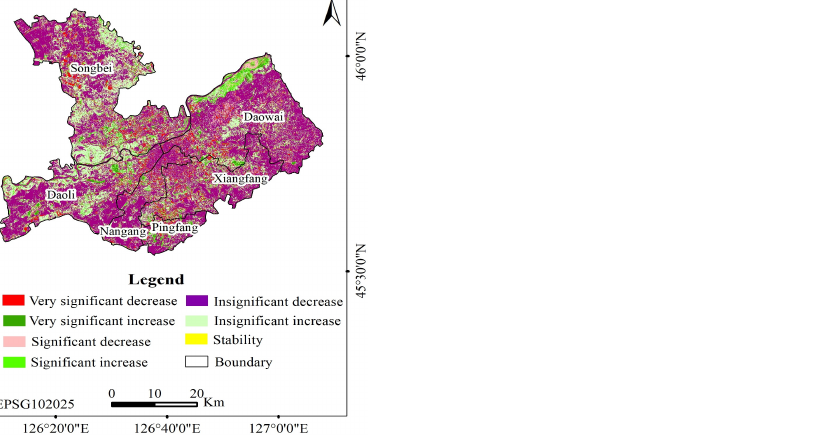
Figure 8. Spatial distribution of vegetation coverage trends between 2004–2020.